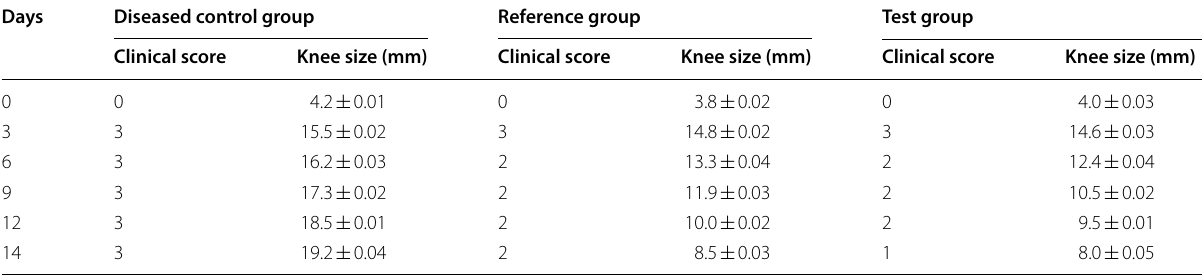
Data are represented as mean